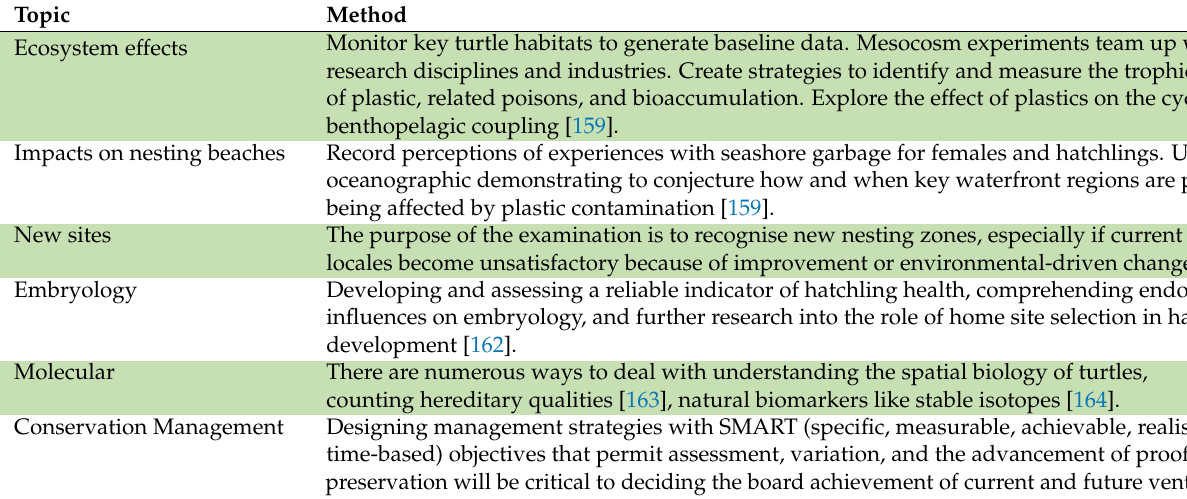
Table 4. A summary of recommended future research